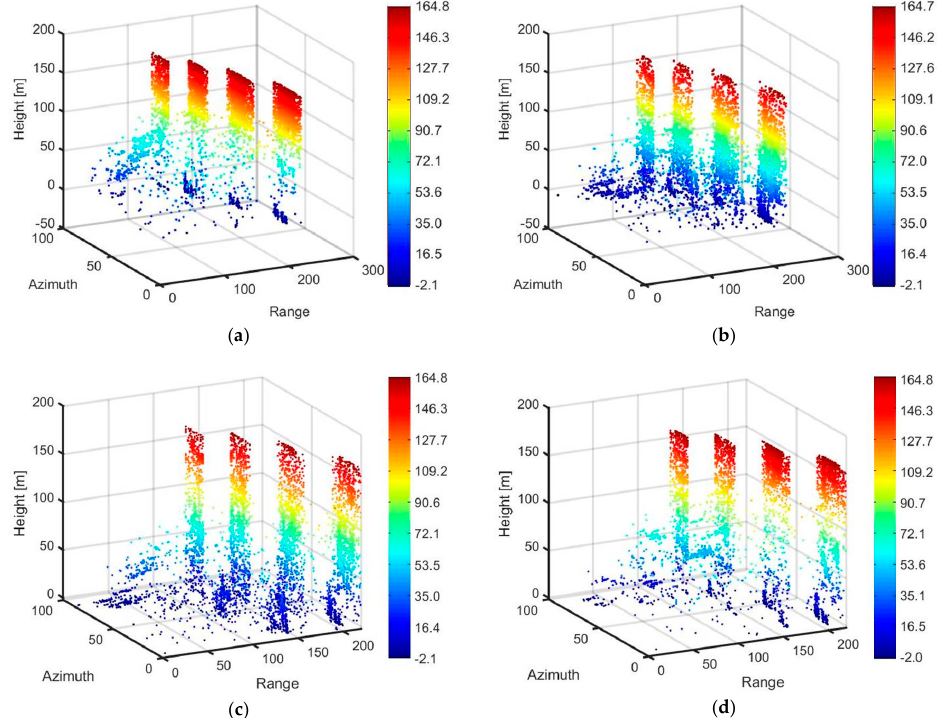
Figure 12. 3D distribution of scatters reconstructed by TWIST for Longzhimeng Changyuan using COSMO-SkyMed orbits ( a ) the corresponding MRA orbits ( b ) random orbit configuration 1 ( c ) and random orbit configuration 2 ( d ), respectively.